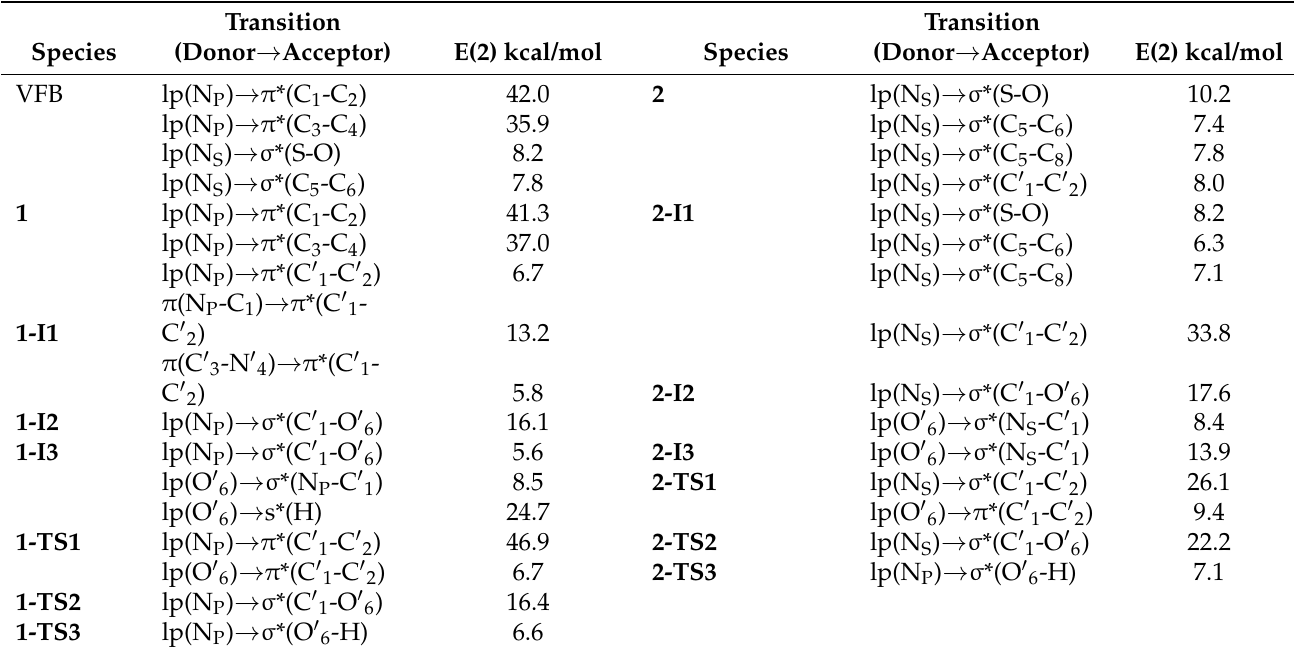
Table 1. Selected natural bond orbital (NBO) electronic transition of key elements (a) involved in the photouncaging reaction and their corresponding stabilization energies